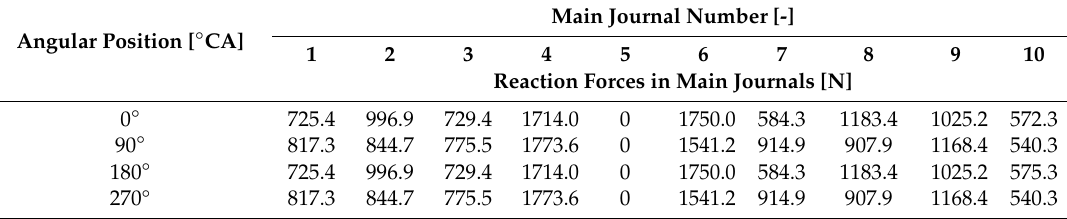
Table 2. Changes in the reaction forces where the supports contact each main journal when the shaft rotation angle was changed by 90 ◦ with one of the supports (of journal no. 5 counting from the timing gear end) o ff set downwards by 0.03 mm relative to the